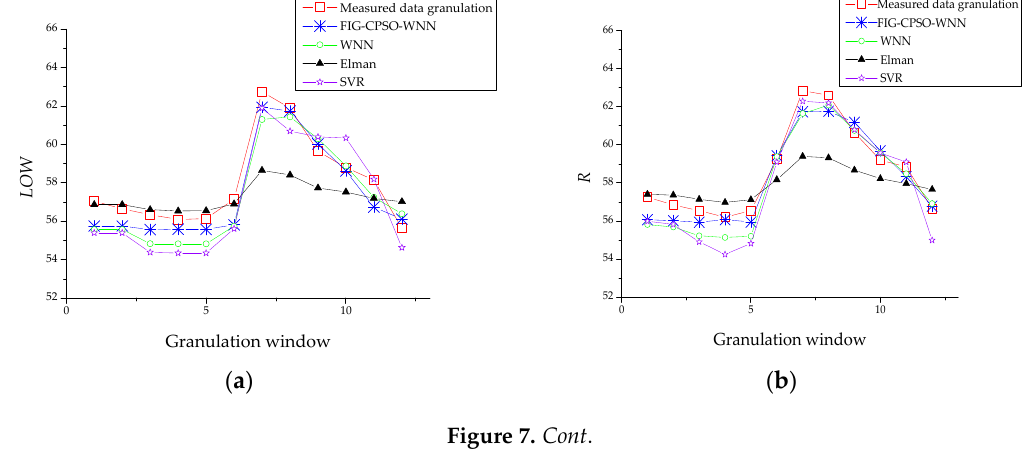
Figure 6. Comparison of prediction error.